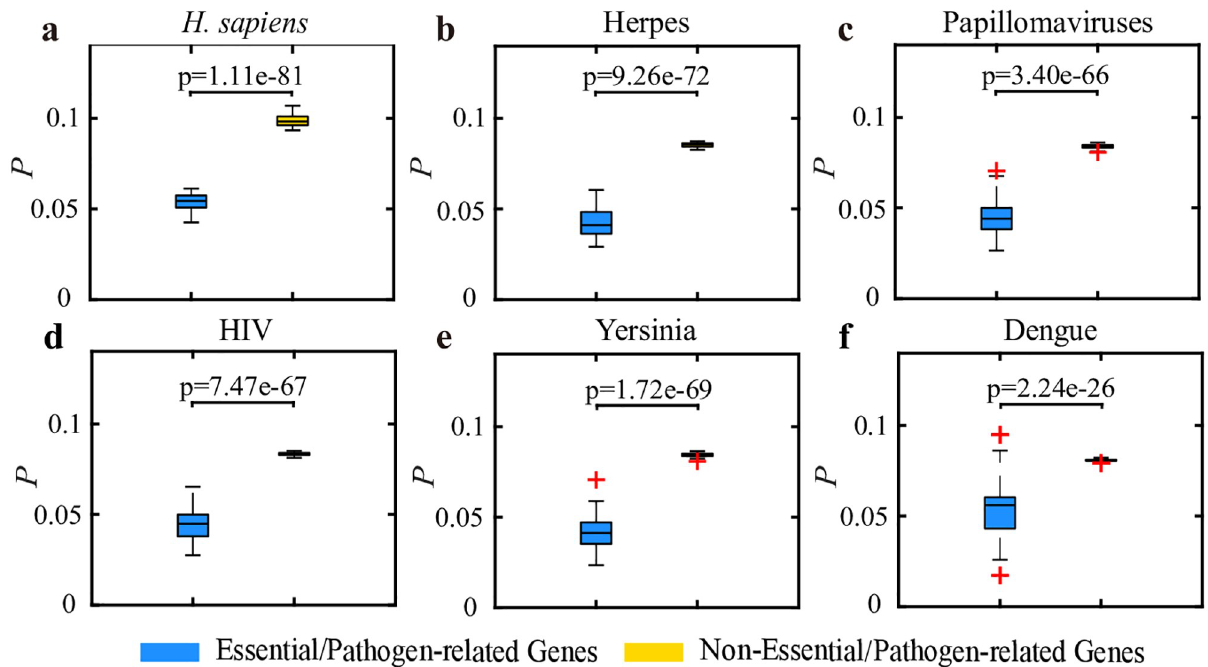
Fig 3. Distributions of the driver nodes in different gene categories. (a) H. sapiens , (b) Herpes, (c) Papillomaviruses, (d) HIV, (e) Yersinia, (f) Dengue. We obtain 100 minimal driver node sets and calculate the fractions of essential or pathogen-related genes among the driver node sets of all essential or pathogen-related genes (left, blue box), as well as the fractions of non-essential or nonpathogen-related genes among the driver node set of all non-essential or nonpathogen-related genes (right, yellow box), respectively. Then we obtain the average value. The red crosses represent the outliers, and the p-value is calculated by the